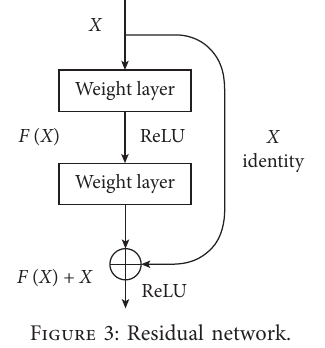
Figure 3: Residual